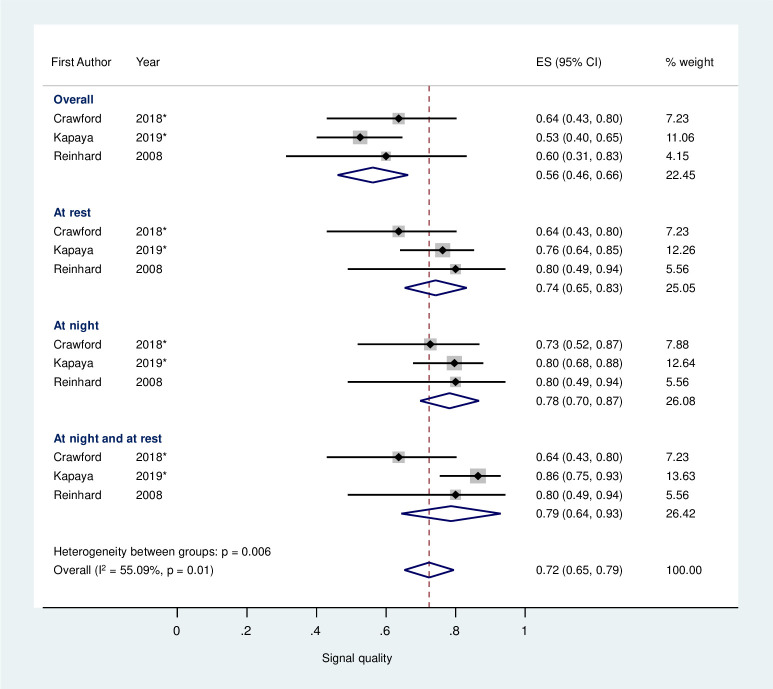
Estimated average signal quality of fetal electrocardiograph recordings depending on time of day from three studies.Black markers represent the signal quality with 95% confidence intervals (CI) (whiskers). The size of each grey square represents the relative weight in the meta-analysis. The diamond represents the signal quality summary value. Asterisk (*) represents studies which had the median and interquartile range/range data converted to the mean and standard deviation. All studies included used the Monica AN24 device.